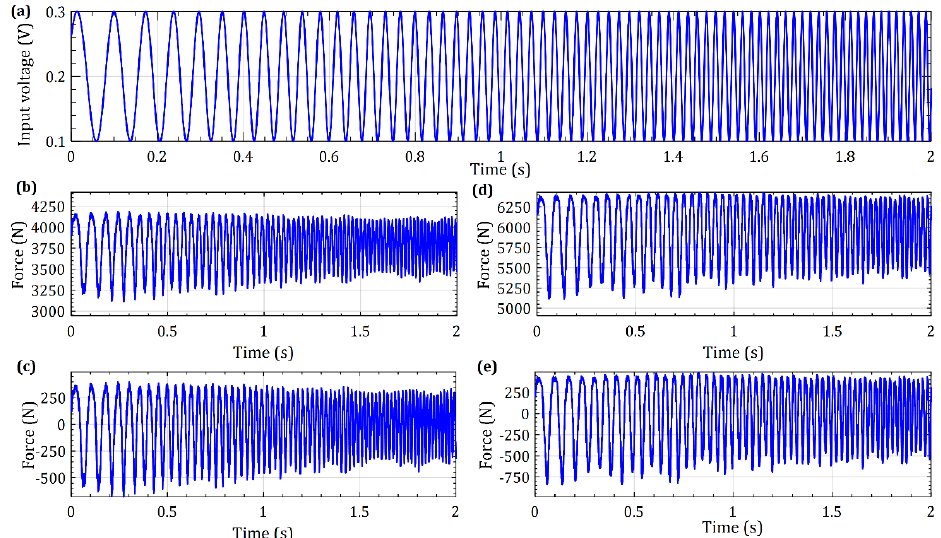
Figure 17. Supplied voltage and measured force signals for different experimental conditions; ( a ) input voltage to the servo valve-100 mV AC and 200 mV DC; ( b ) measured static and dynamic force controlled by servo valve; ( c ) measured dynamic force with subtracted static force controlled by servo valve; ( d ) measured static and dynamic force controlled by servo valve + pressure in the rear chamber; ( e ) measured dynamic force with subtracted static force controlled by servo valve + pressure in the rear chamber.